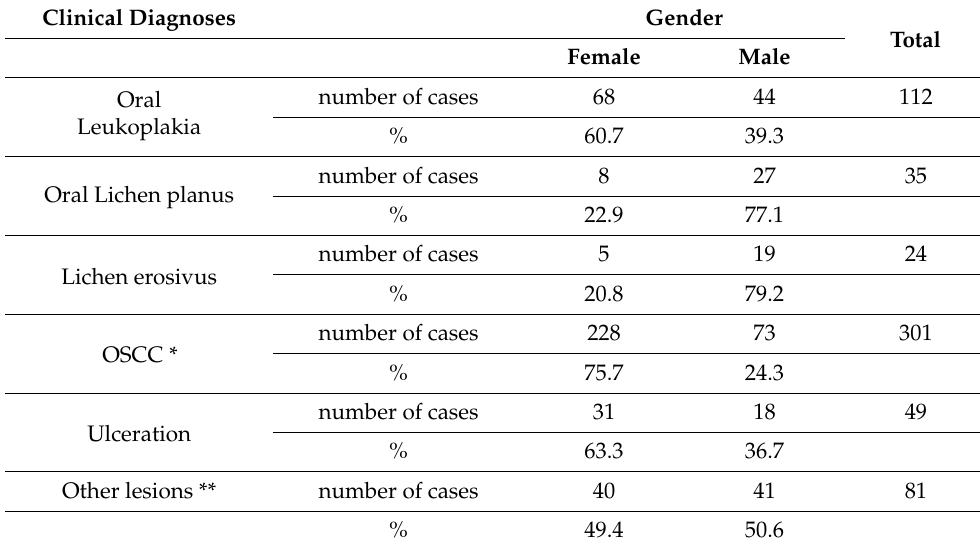
Table 1. Distribution of the most frequently occurring clinical diagnoses according to the gender of the